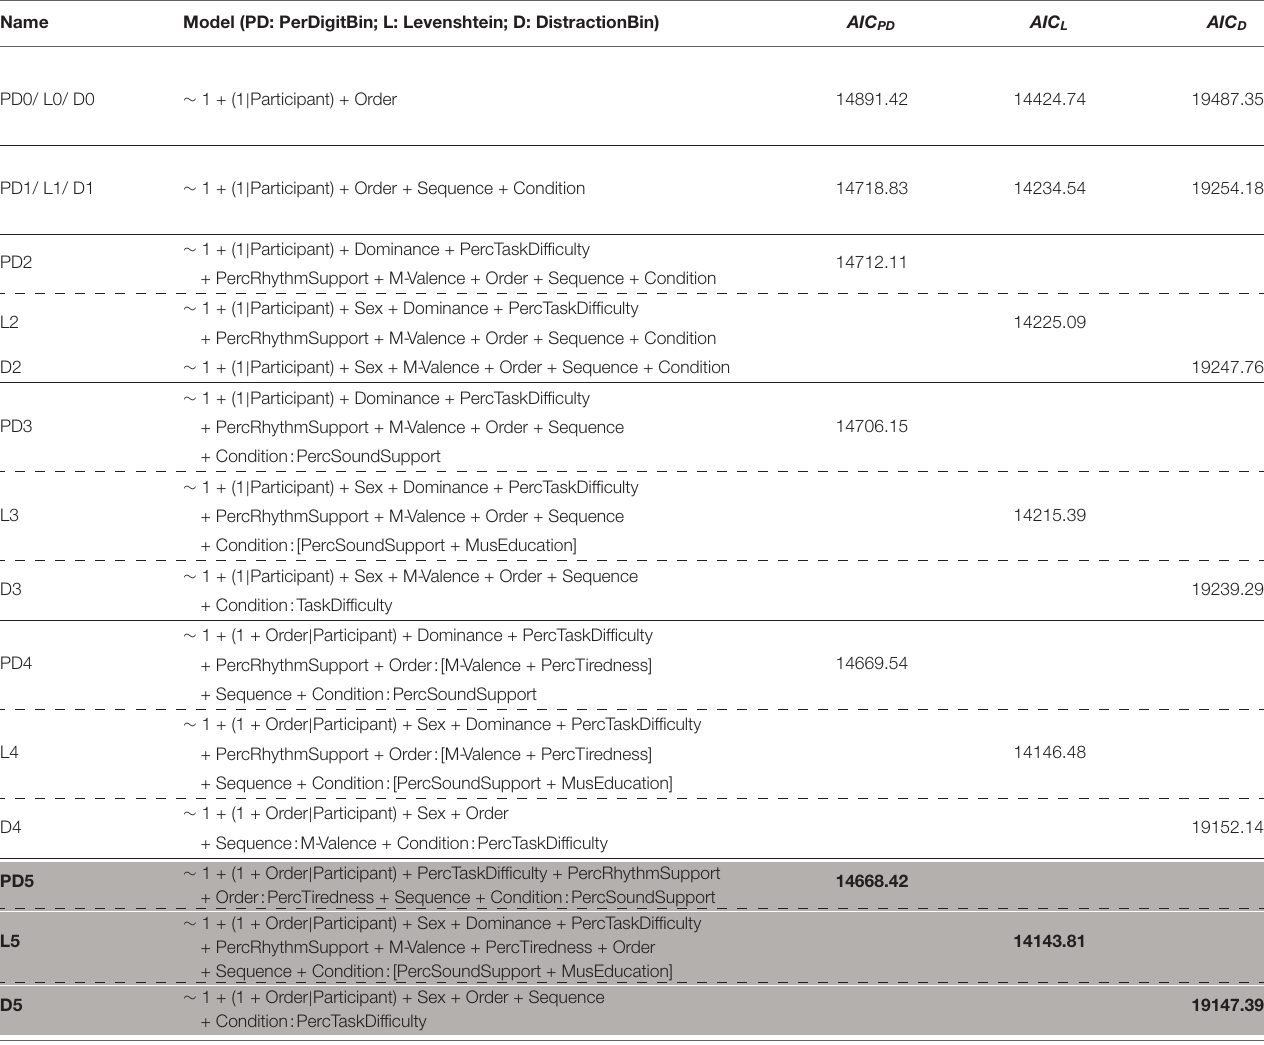
TABLE 1 | Step by step multilevel model